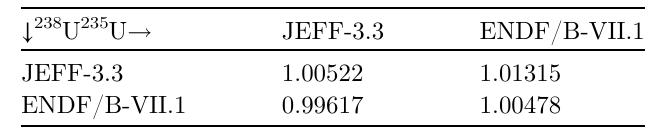
Table 1. Comparison of k calculation for IMF7 by eff mixing the sources of the evaluations for 235 U and 238 U. In all cases, the probability tables are included. The statistical uncertainties are about 25